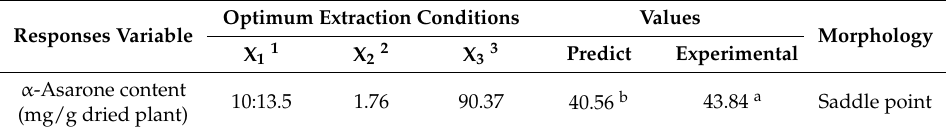
Table 5. Predicted and experimental values of the response at optimized